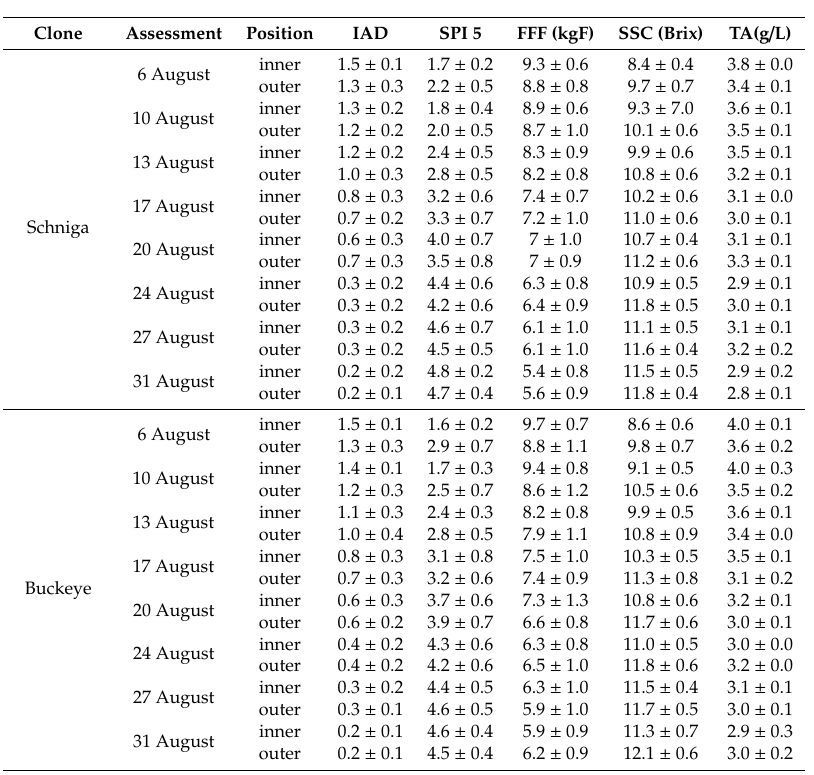
Table A1. Changes of IAD and standard maturity parameters in cv. ‘Gala’ apples during ripening in season 2015. The measurements (mean and standard deviation) of IAD were carried out on sun-exposed fruit side, with all other measurements carried out on the transition between the sun-exposed and shaded fruit side.